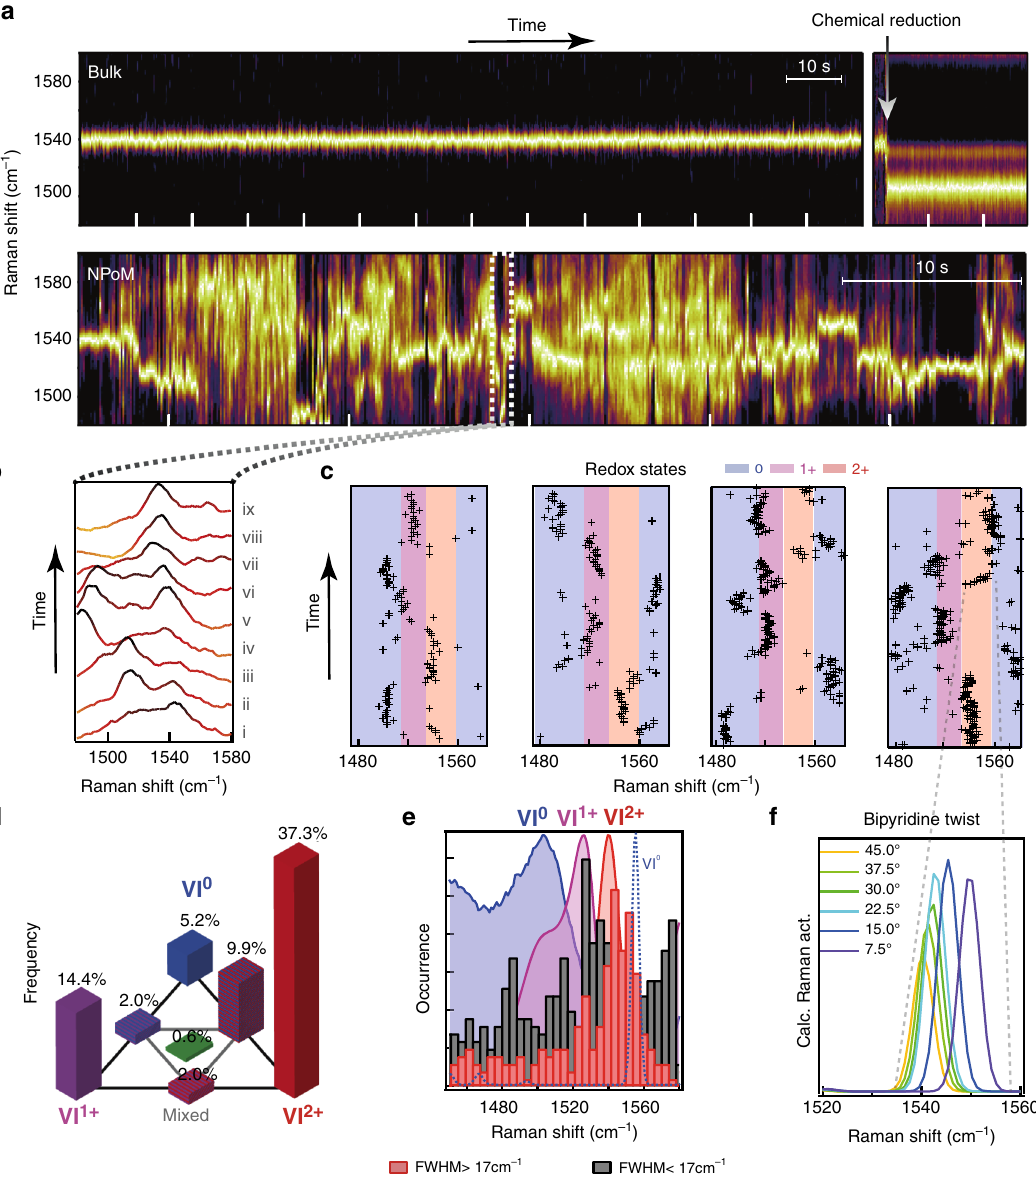
Fig. 4 Single-molecule Redox analysis in individual NPoM geometries. a Normalised SERS time scans of VI with CB[8], ticks represent 10 s: ( top ) bulk measurement in solution with NaBH 4 added after 115 s ( arrow ); ( bottom ) NPoM measurement taken over 70 s. b Short (0.9 s) segment from NPoM time scan showing the reduction and oxidation processes of VI . c Evolving vibrational peak positions from several NPoM constructs compared to redox states of Fig. 3b. d Tri-analyte analysis showing the rarity of seeing more than one redox state, by correlating occurrences of one or several sets of identi fi ed SERS peaks (remaining 29.% have no peaks detected, not shown). e Distribution of peak positions sorted into histograms of wide FWHM > 17 cm − 1 ( red ) and narrow peaks FWHM < 17 cm − 1 ( grey ). f , Spectral change in calculated 1542 cm − 1 peak as a result of twisting between pyridine